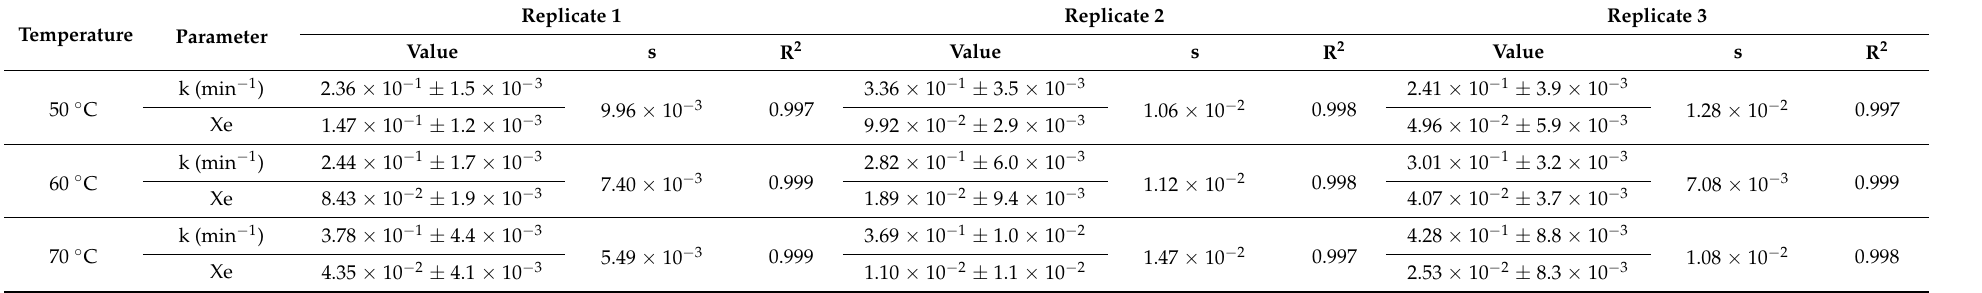
Table 5. Parameters of the Newton model for the replicates processed at 50 ◦ C, 60 ◦ C and 70 ◦